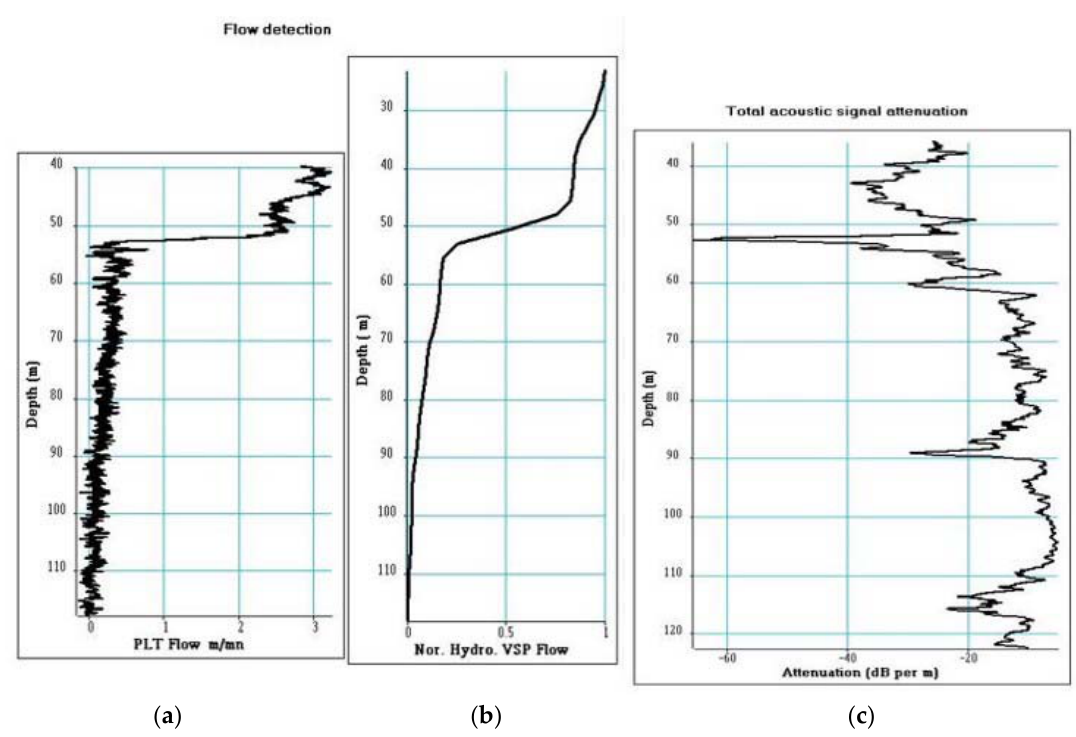
Figure 13. Comparison between ( a ) production logging tool (PLT) flow, ( b ) normalized VSP flow and ( c ) total acoustic signal attenuation.